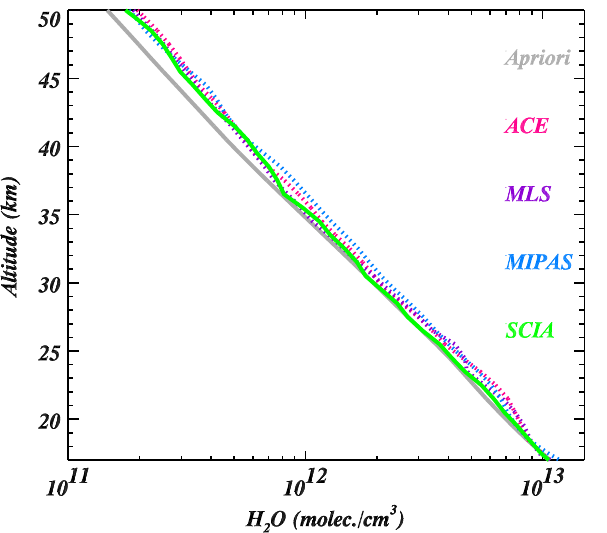
Fig. 13. SCIAMACHY–ACE comparison statistics for the period 2004–2009 based on 302 collocations with combined ACE-FTS sunrise and sunset